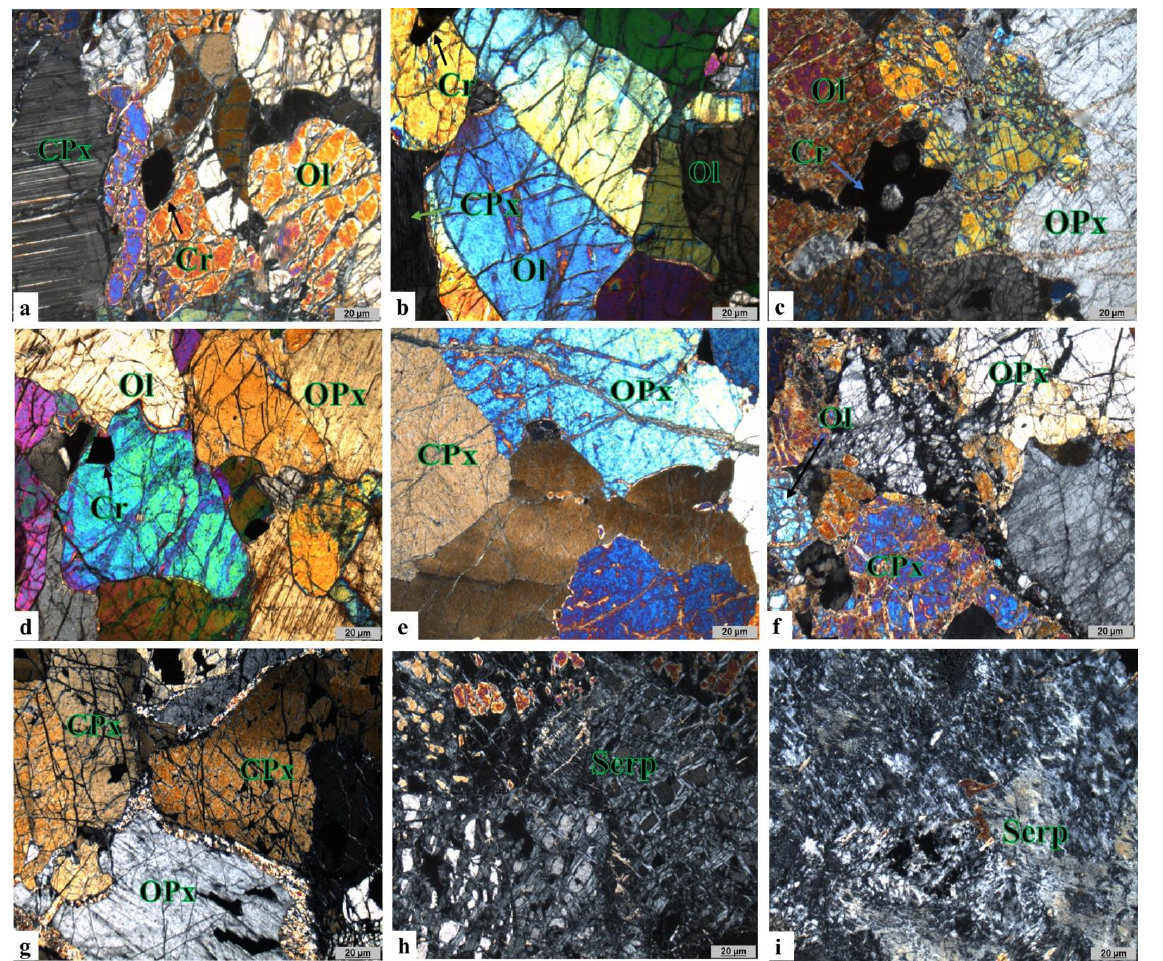
Figure 9. Photomicrographs of the collection of specimens and describing their mineral assemblages and possible rock types; ( a ) dunite, ( b ) dunite, ( c ) harzburgite, ( d ) harzburgite, ( e ) pyroxenite, ( f ) websterite, ( g ) pyroxenite, ( h ) serpentinite, and ( i ) serpentinite. CPx, clinopyroxene; Ol, olivine; OPx, orthopyroxene; Serp, serpentine; Cr, chromite.